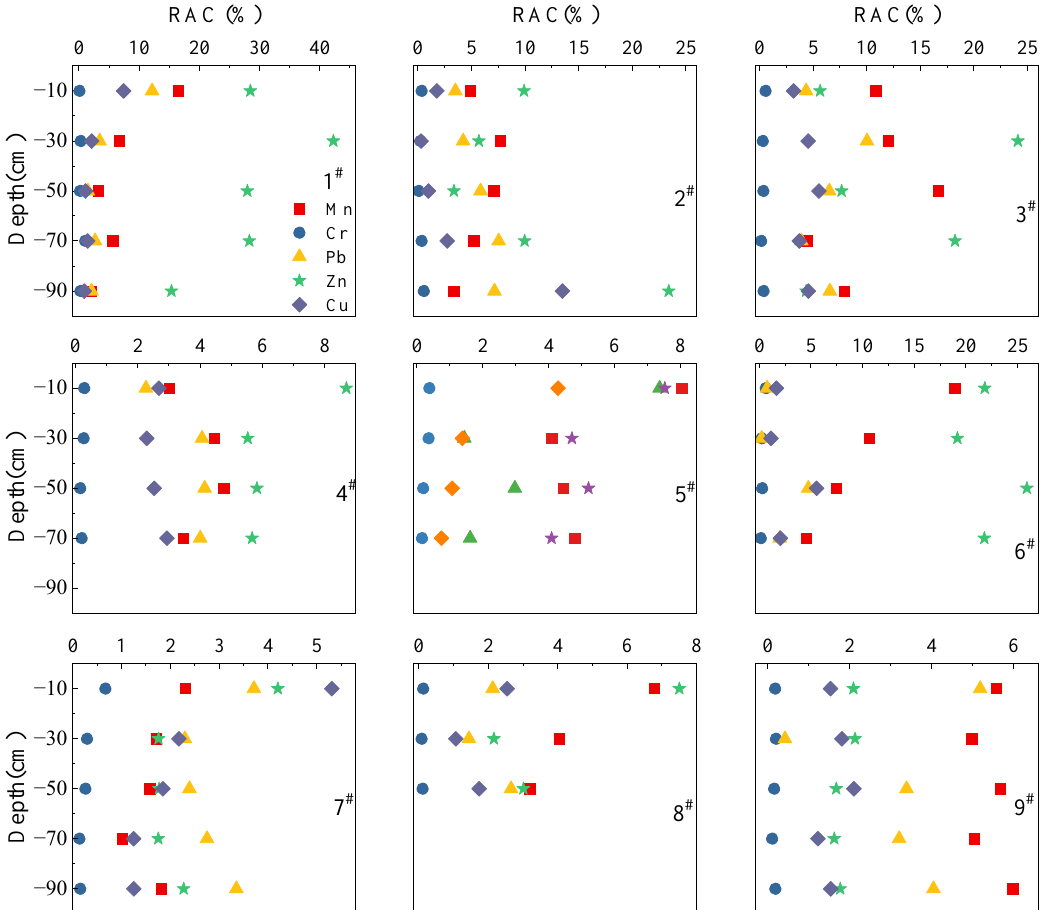
Figure 8. RAC-based assessment of soil heavy metal pollution levels and ecological risks. (Note: Red squares represent Mn, dark blue circles represent Cr, yellow triangles represent Pb, green pentagrams represent Zn, and purple diamonds represent Cu) .